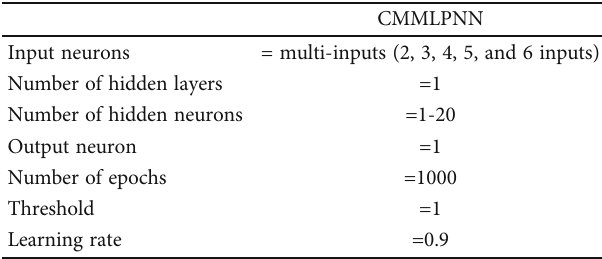
Table 1: Proposed cooperative multi-input multilayer perceptron neural network designed